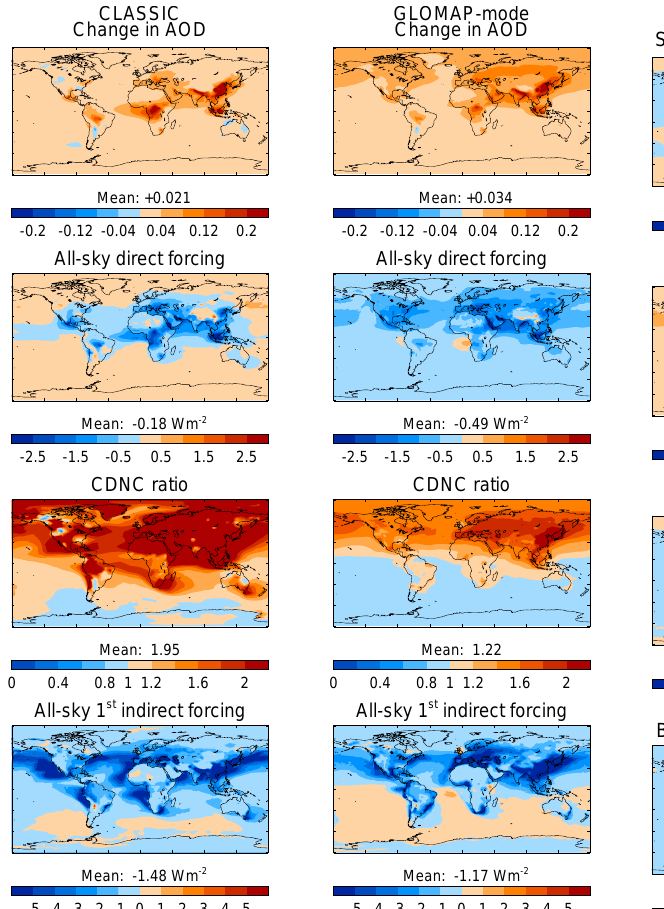
Fig. 7. Top row: change in total aerosol optical depth (AOD) be- tween simulations with emissions for the years 2000 and 1850 using the CLASSIC (left) and GLOMAP-mode (right) aerosol scheme. Second row: all-sky direct radiative forcing at the top of the atmo- sphere (TOA), in Wm − 2 . Third row: ratio between cloud droplet number concentration (CDNC) simulated with 2000 and 1850 emis- sions. CDNC is integrated over the lowermost 10km of the atmo- sphere. Bottom row: all-sky first indirect radiative forcing at the TOA, in Wm − 2 .